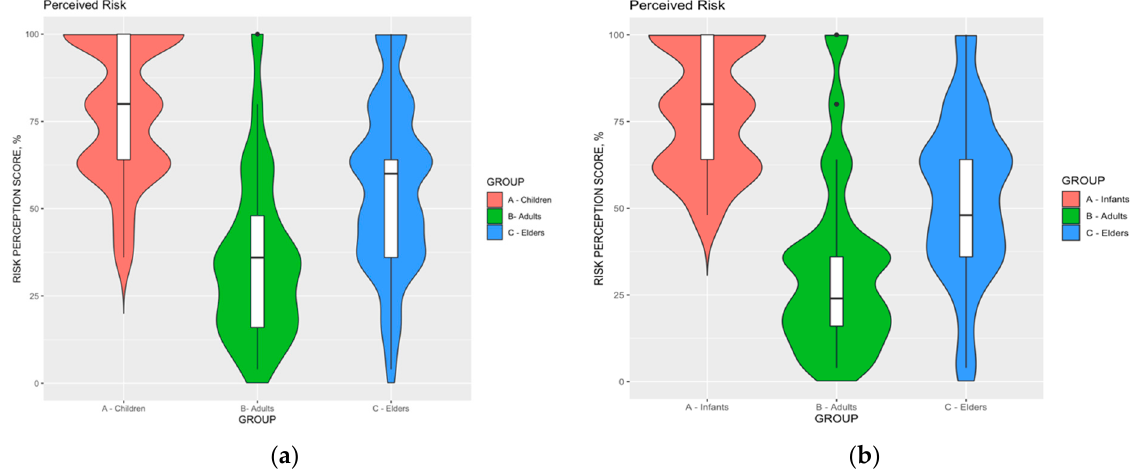
Figure 3. Violin plot with the comparisons of risk perception score (potential range: 0.0–100%) for Respiratory Syncytial Virus (RSV) infections in infants, adults, and elders. ( a ) All of the respondents’ (No. 389) RPS score for RSV infection in infants (78.3% ± 19.5, range 36.0% to 100%) were substantially higher than that for adults (35.5% ± 22.9, range 4.0% to 100; p < 0.001), and elders (56.1% ± 23.9, p < 0.001). ( b ) Only respondents having previously cared for RSV cases in previous 5 years (No. 163): RPS score for RSV infection in infants (78.3% ± 17.8, range 48.0% to 100%) was substantially higher than that for adults (32.7% ± 24.9, range 4.0% to 100; p < 0.001), and elders (53.6% ± 23.6, p < 0.001).